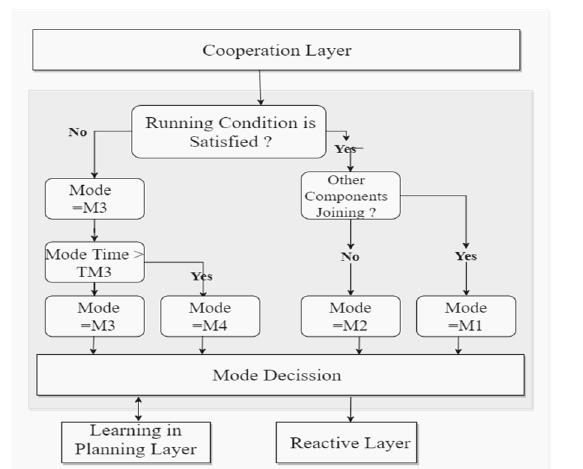
Fig. 6: Mode selection in planning